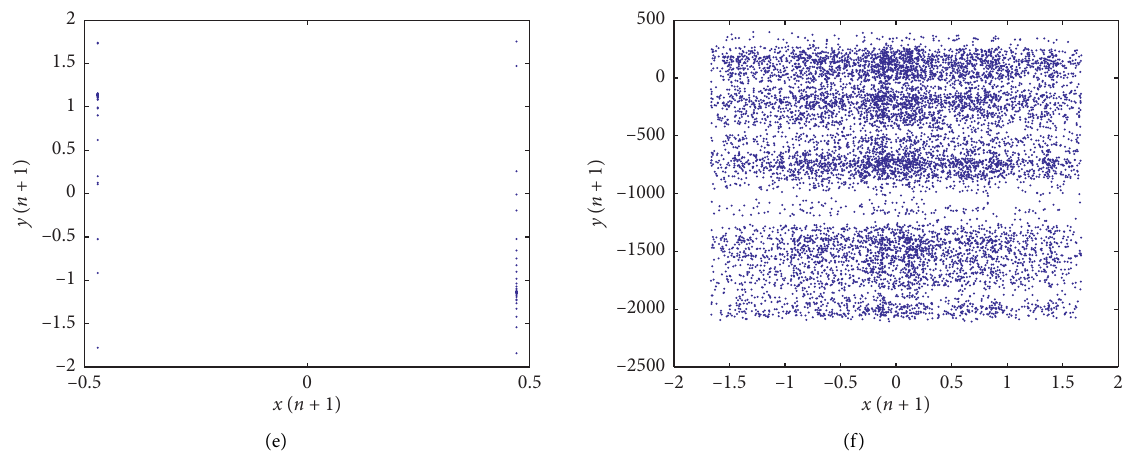
Iteration property at (a) r � 7.5, ( 0 ) ( 0 ) � 0 . 02 ,y � 0 . 02 , and a � 1 . 5 .